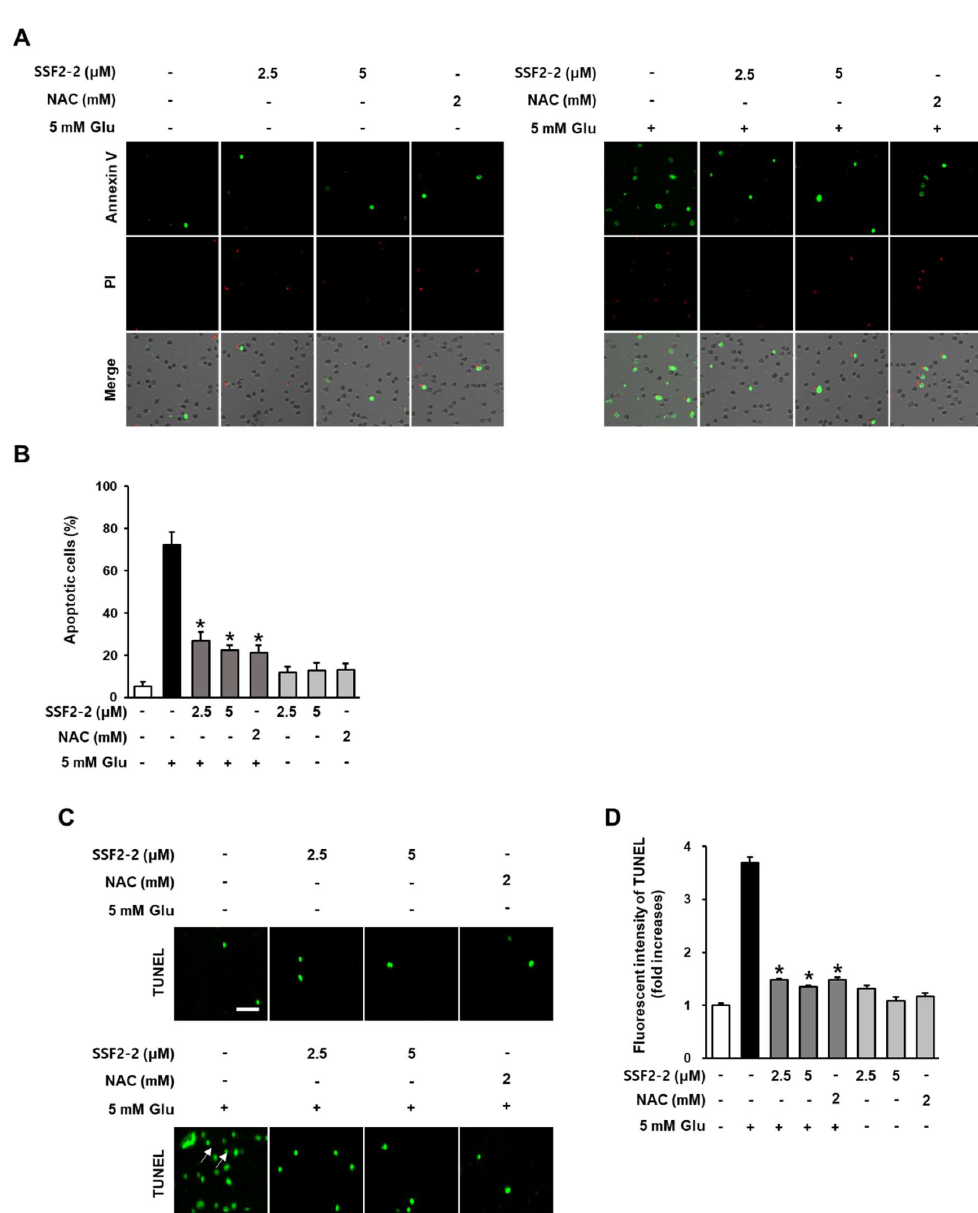
Figure 7. E ff ects of SSF2-2 on glutamate-induced apoptotic cell death. HT22 cells were incubated for 24 h with 5 mM glutamate (Glu) with or without compound SSF2-2 and N-acetylcysteine (NAC), and then stained with annexin V / propidium iodide (PI) or TUNEL. ( A ) Fluorescent images were collected using a Tali image-based cytometer after staining with annexin V / PI. ( B ) % of apoptotic cells were calculated using TaliPCApp (version 1.0). ( C ) Fluorescent images collected using a fluorescent microscope after staining with TUNEL. ( D ) Fold increases in fluorescent intensity of TUNEL. White scale bar, 40 µ m. Data represent the mean ± S.E.M., n = 3, * p < 0.05 compared with the glutamate-treated